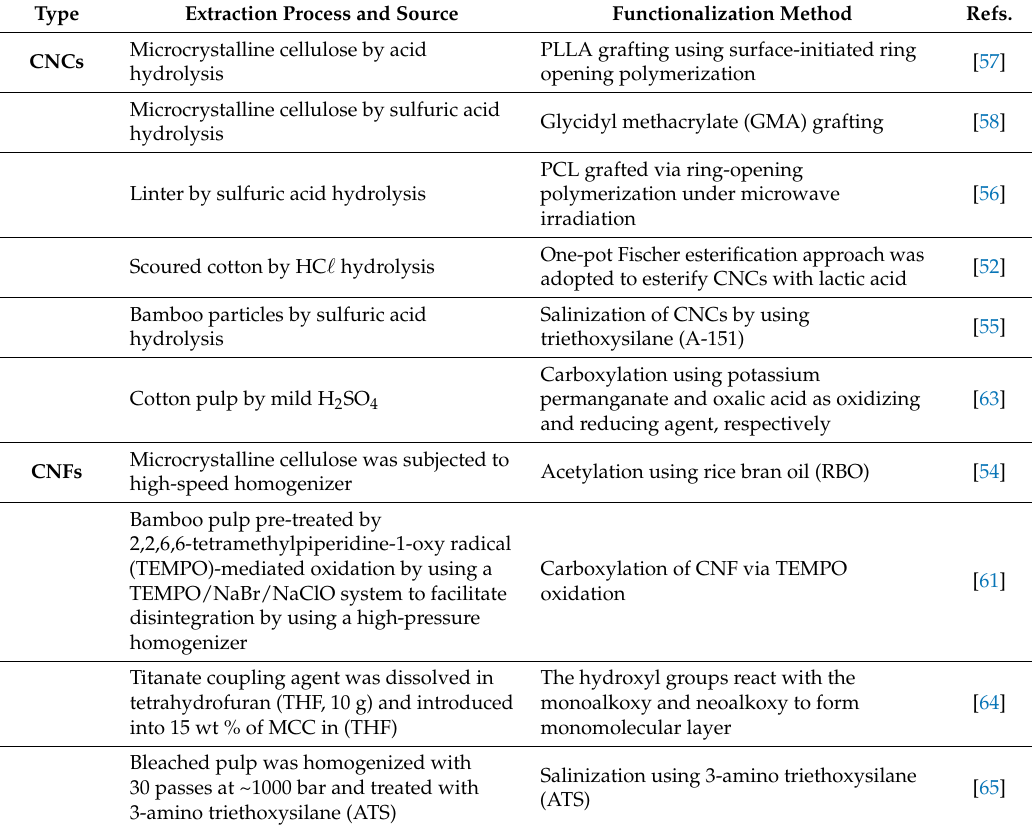
Table 3. Selected studies on surface modifications of CNMs for PLA